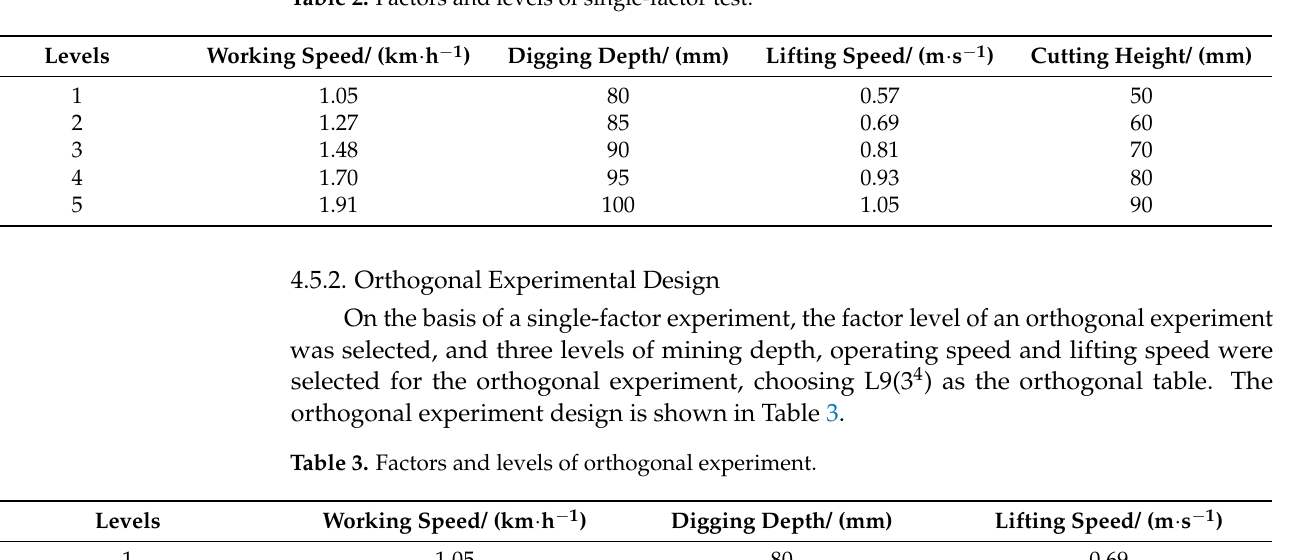
Table 2. Factors and levels of single-factor test.